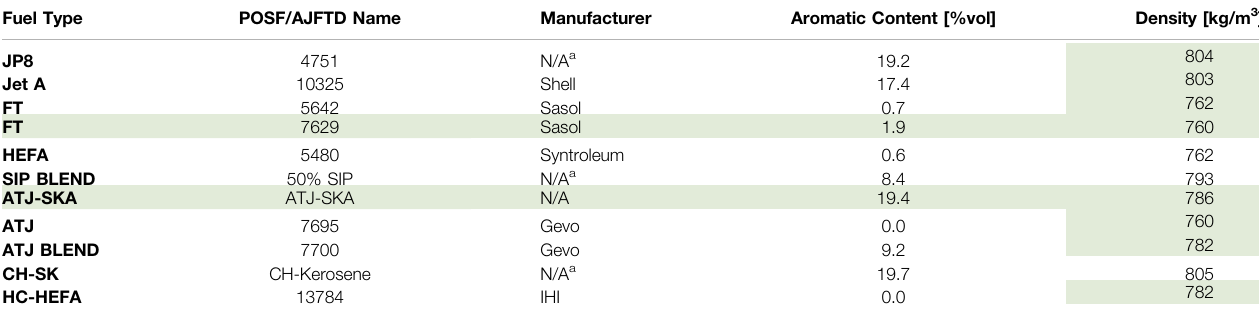
TABLE 1 | Examples fuels available on AJFTD website.